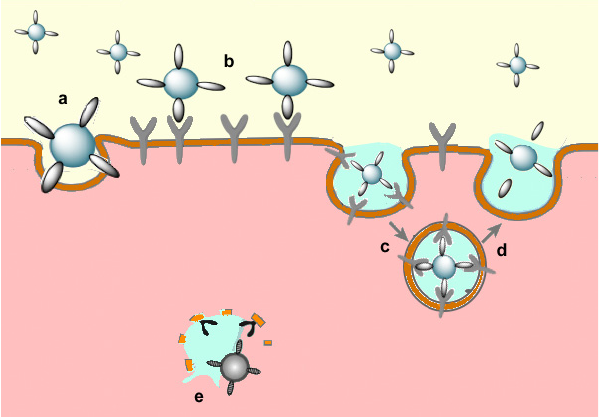
Fig. 6. Surface functionalized nanoparticles interacting with cells. (a) Nanoparticles bind to receptors on the membrane and induce a signaling cascade without entering the cell. (b) Nanoparticles can also be internalized and exocytosed by the cell, without ever leaving the vesicle. (c) Internalized nano- particles can escape the vesicle and interact with various organelles. (d) Nanoparticles can interact nonspeci¯cally with the cell surface membrane, and be